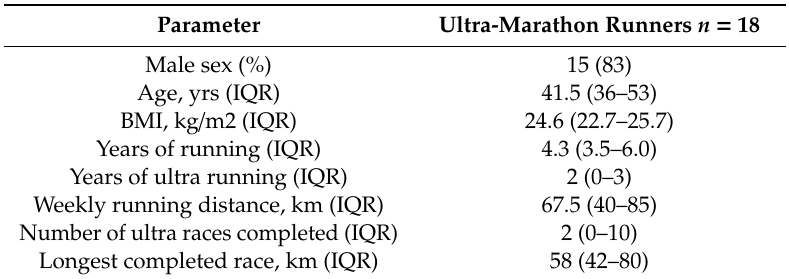
Table 1. Baseline and running characteristics of the studied